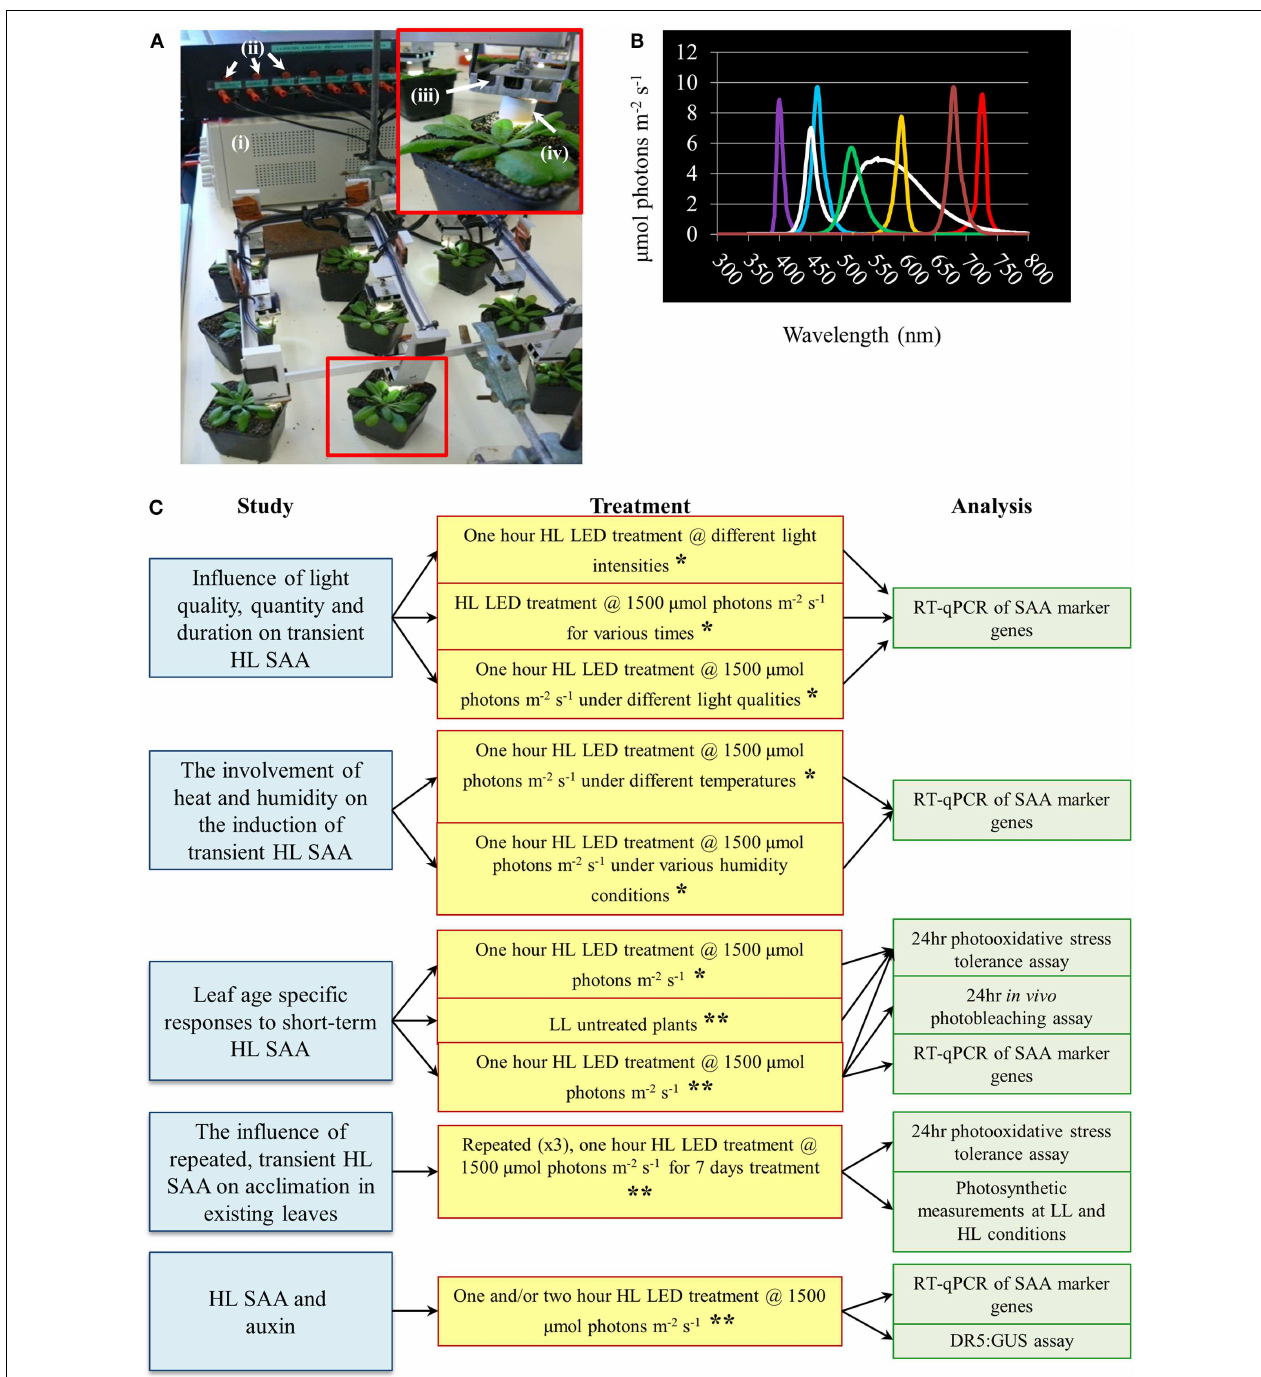
diagram of the main areas of study, light treatments, and methods of analysis conducted throughout the research article. For all light treatment mature plants of approximately 4weeks old grown under normal light conditions as detailed in Section “Materials and Methods” are used. For more detail on each individual treatment and analysis refer to Section “Materials and Methods.” *Experiment conducted irrespective of leaf position. **Experiment conducted taking leaf position in to